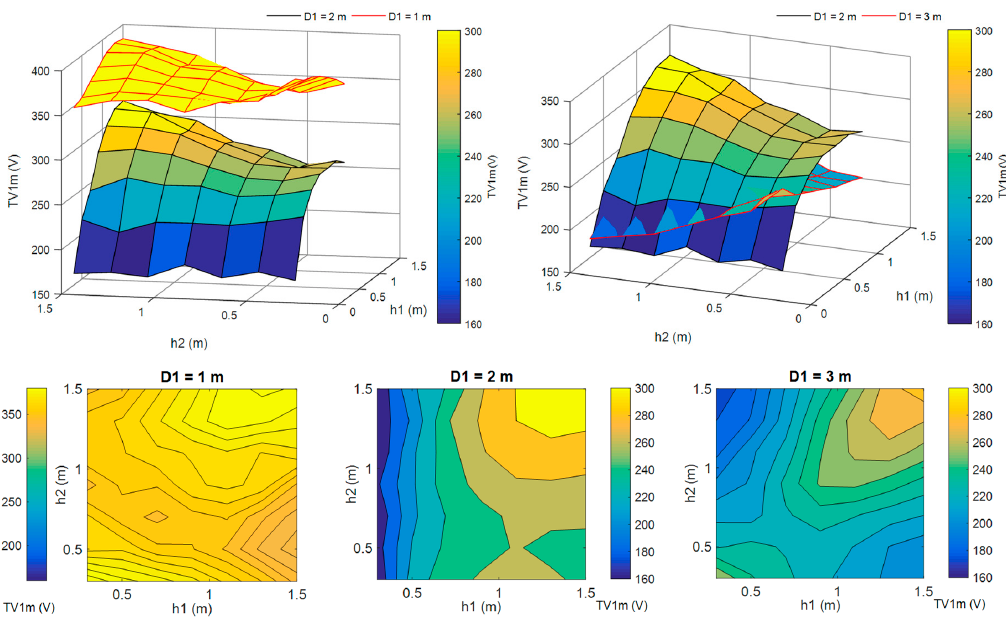
Figure 2. TV1m solution surfaces for ES with diameters D 1 = 1–3 m, D 2 = 4 m, ρ 1 = 500 Ω m, ρ 2 = 100 Ω m, H = 2 m.